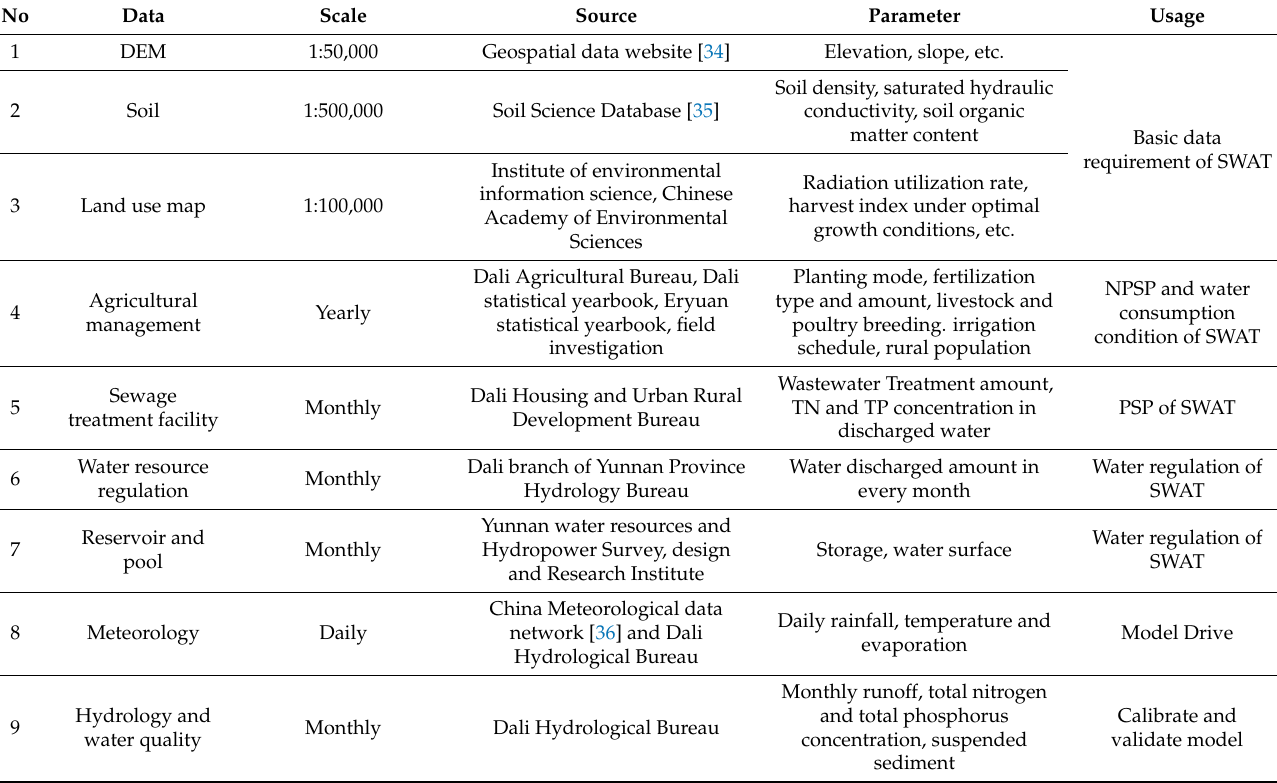
Table 1. Data and sources used in this